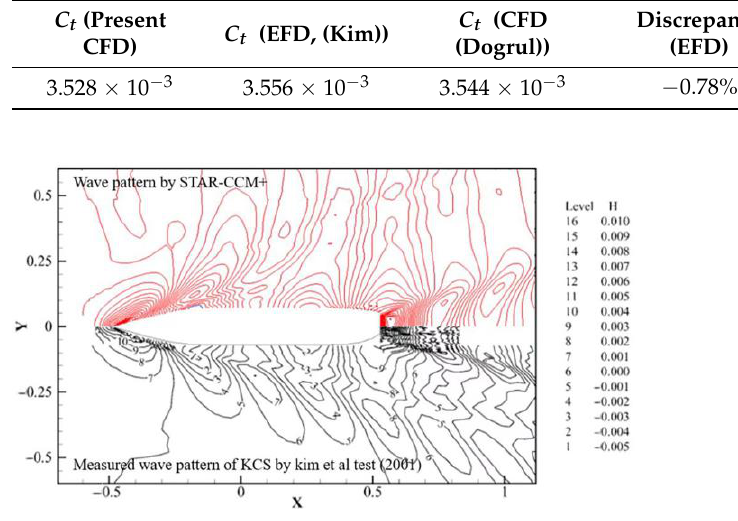
Figure 6. Comparison of simulated and measured waveforms.